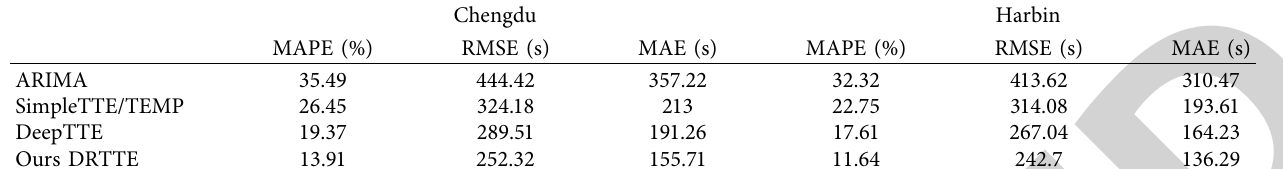
Table 5: Effectiveness of different component.